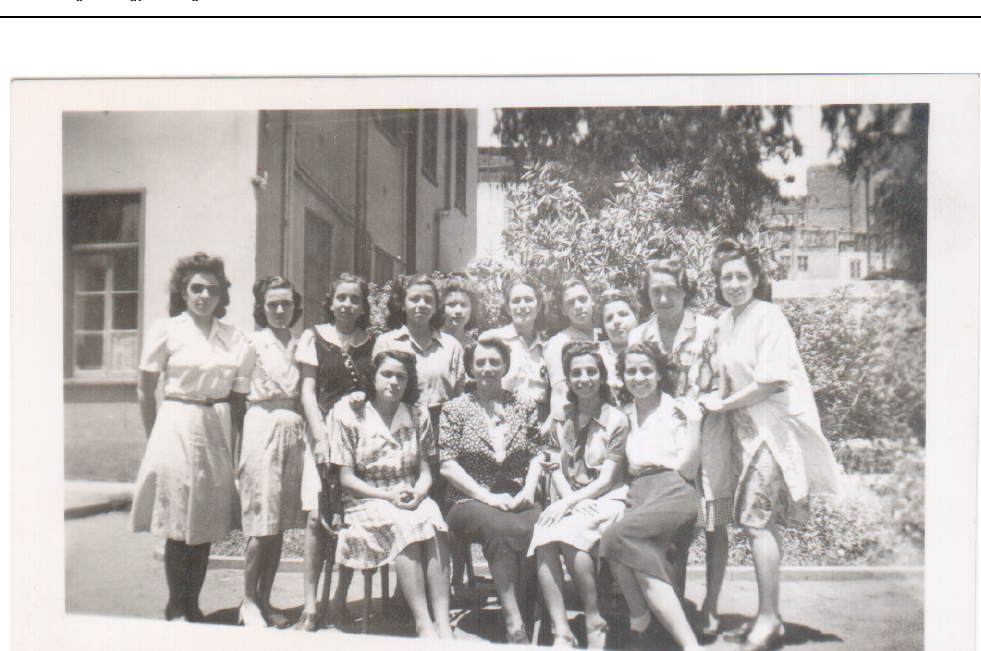
Figure 1. Photograph of students at the Higher Institute Women Teachers of the Fine Arts in Bulaq circa 1947–1949, with Menhat Helmy seated at the far right with their art teacher, seated second from left; Menhat’s sister Reaya, also a student at the school is standing at the far left. The photograph may also be showing Gazbia Sirry. Courtesy of estate of Menhat Helmy.